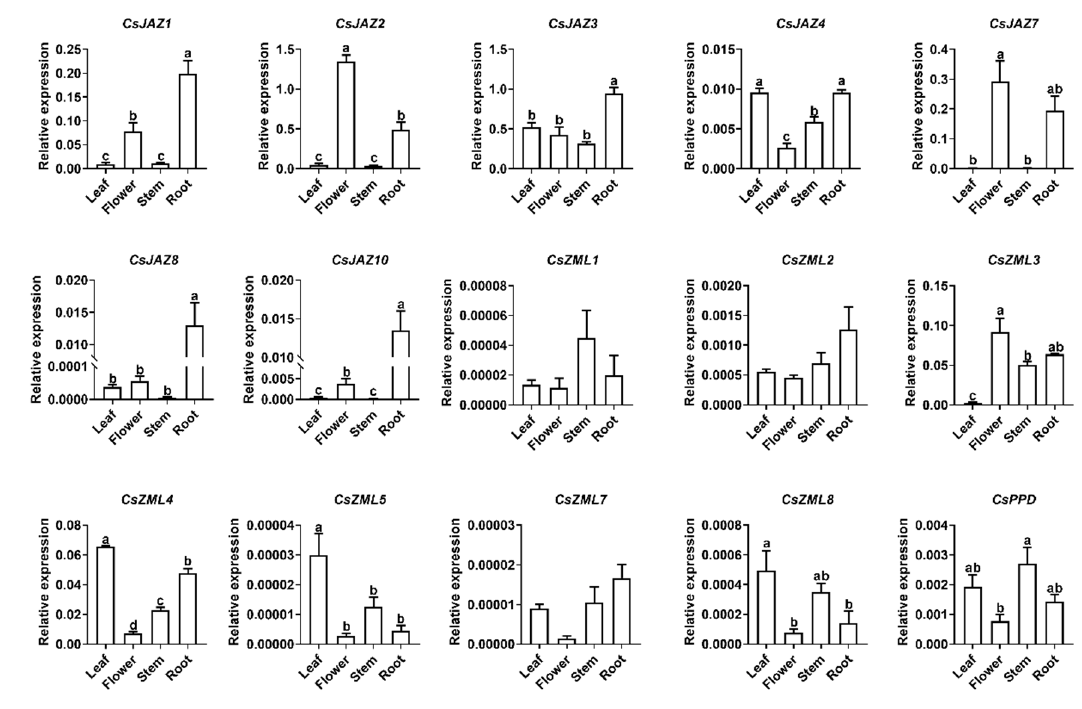
Figure 4. Expression profile of CsTIFY genes in four organs. Data are shown by the mean + SE, different letters indicate significant difference among different organs (Turkey’s honest significant difference (HSD) post-hoc test, p < 0.05, n =